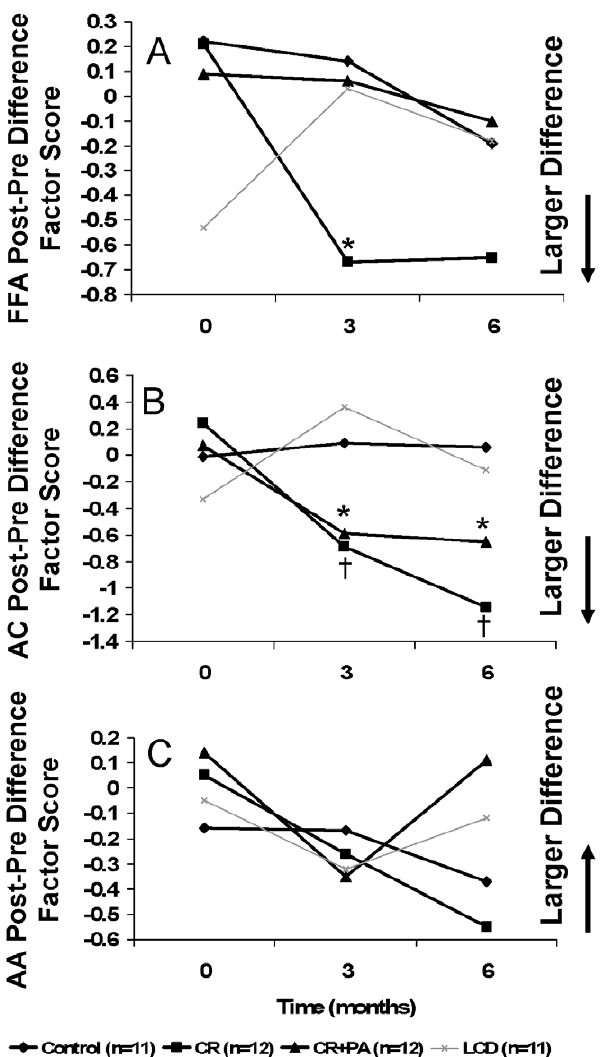
Figure 2. Trajectories of Fasting to Postprandial Metabolic Intermediate Concentration Changes over Time by Interven- tion Group. Fasting to postprandial difference (FPPD) scores were computed as postprandial minus fasting concentration. Difference scores were used in principal component analyses and single component solutions were retained as described in Results. FPPD component scores in Figures A-C were calculated as: (1) FPPD=S1*(I1) + S2*(I2) + … Sk*(Ik); where: I1-ik are the k individual items used in the principal components analysis; S1–Sk are standardized scoring coefficients from the principal component analysis; and, I1-Ik are entered as (I/SdI) for each item. With equation 1, the FPPD component score is the average of the mean post- preprandial differences across items with each item weighted by its standardized scoring coefficient. Mean difference are expressed in standard deviation units. Significant trends (P , 0.10) are identified with an asterisk (*) and significant group by time interactions are indicated with a ( { ). CR=Caloric restriction. CR + EX=Combined caloric restriction